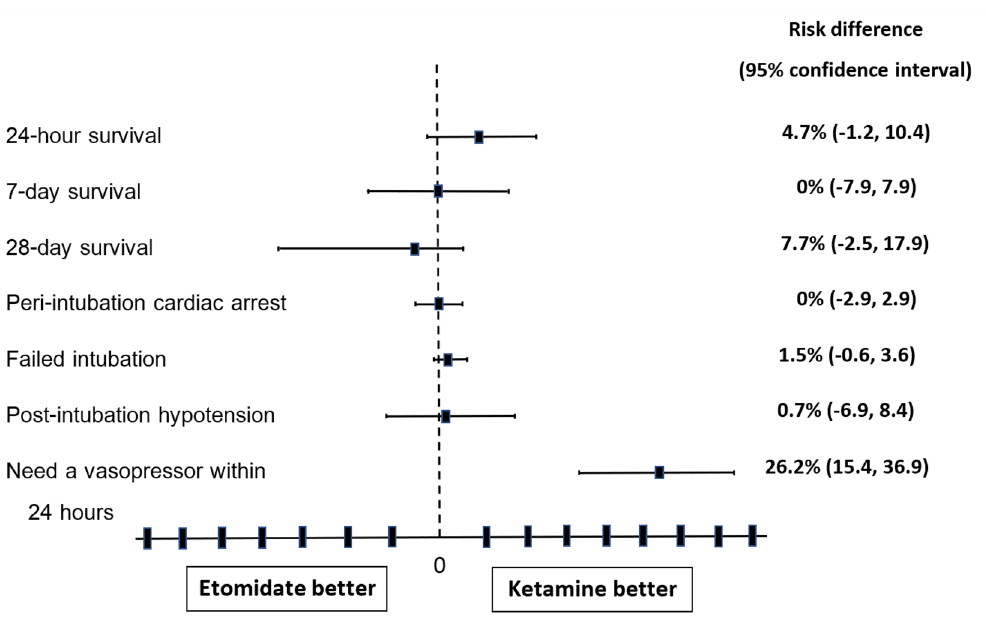
Figure 2. Primary and secondary